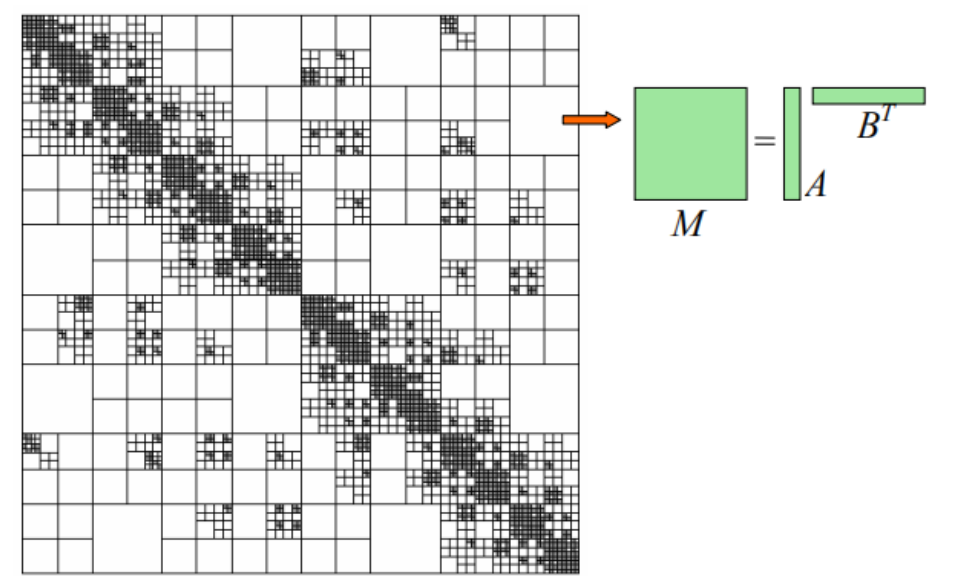
Figure 2. A schematic diagram of a typical H-matrix structure. Black represents full matrix blocks and white represents low-rank matrix blocks.